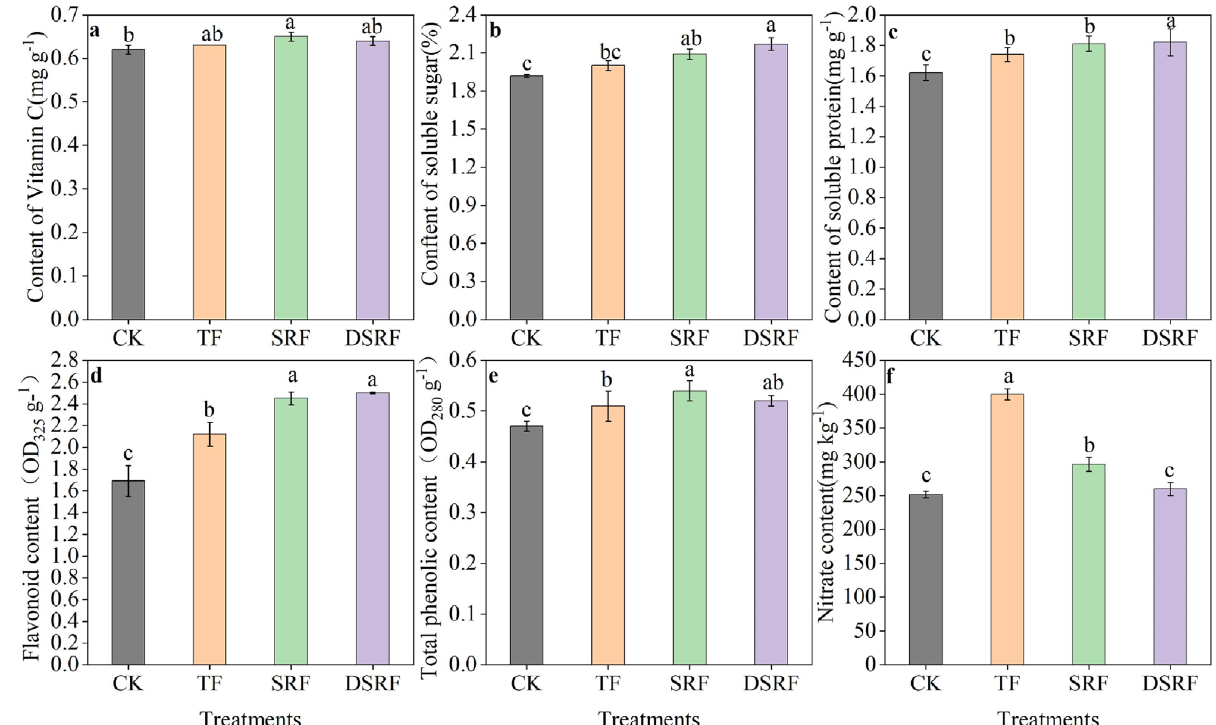
Figure 4. Vitamin C ( a ), soluble sugar ( b ), soluble protein ( c ), flavonoids ( d ), total phenols ( e ), and nitrate ( f ) of wintering Chinese chives as affected by different fertilizer treatments. Lowercase letters indicate significant differences among different fertilization treatments ( p < 0.05). CK no fertilizer, TF traditional fertilization, SRF traditional fertilization with slow-release fertilizer, DSRF decreased fertilization with slow-release